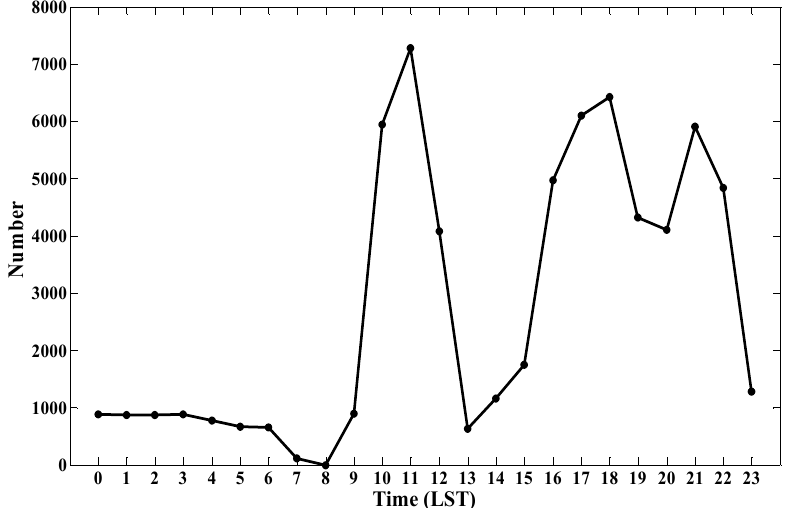
Figure 11. WACAL data acquirability during measurement period.